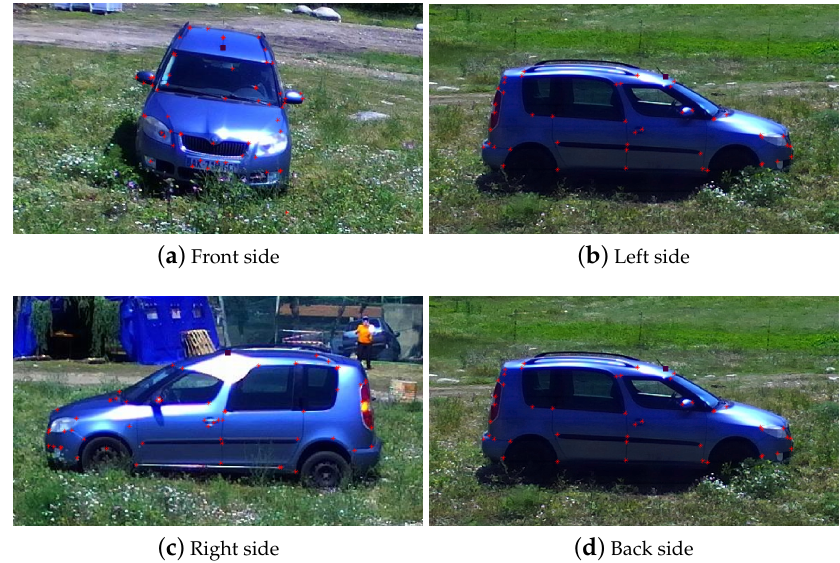
Figure 18. Manually selected points of the car (red stars). The purple square represents the GPS sensor position.